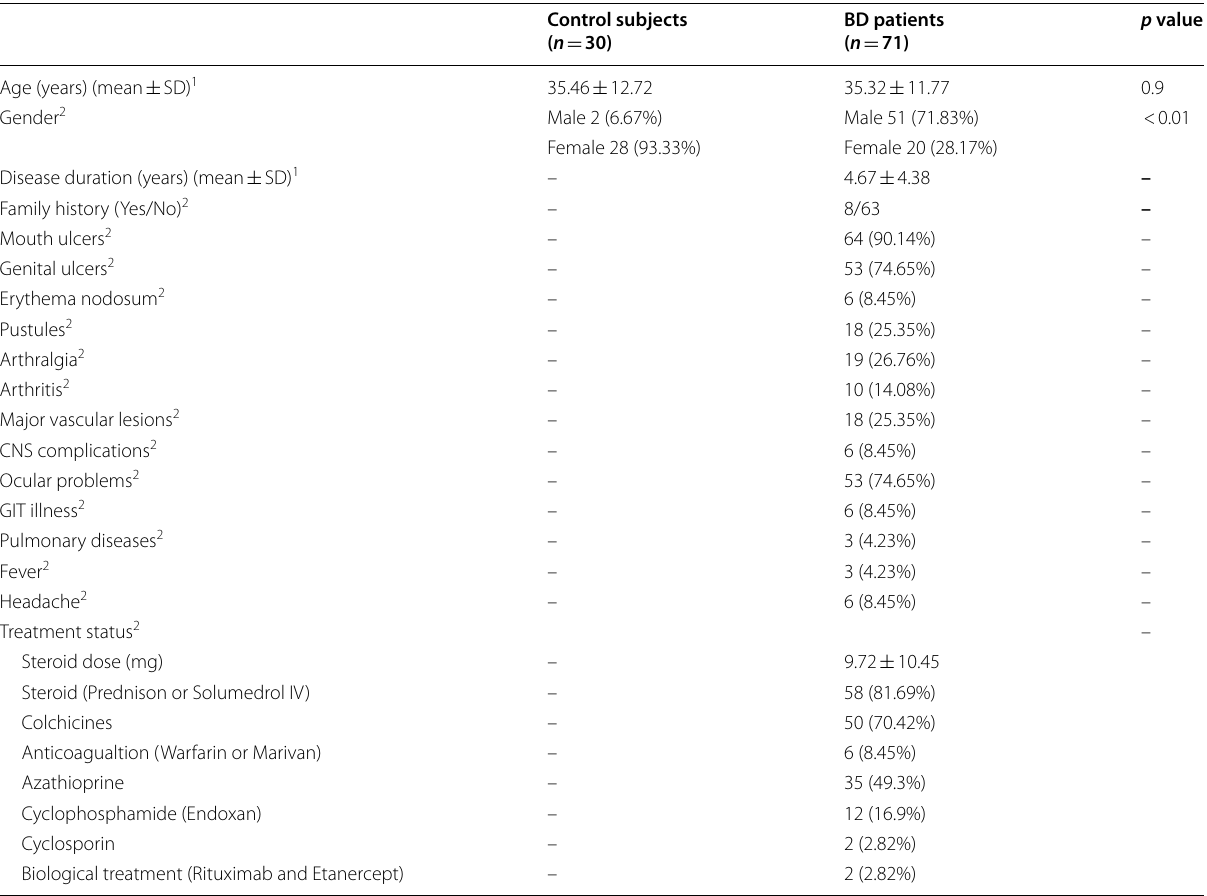
Table 2 Demographic characteristics of all participants